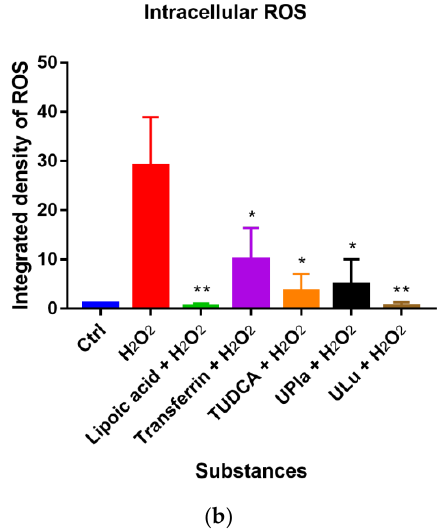
Figure 6. Intracellular ROS levels were detected by DCFH-DA staining ( a ), and the integrated fluorescence density was quantified using ImageJ ( b ). H 2 O 2 raised intracellular ROS levels (green fluorescence), which were reduced by UPla or ULu. Similar effects were observed in the positive control groups with lipoic acid, transferrin, and TUDCA. The results represent similar results of three independent experiments. Values are the mean ± SD, N = 3. * p < 0.05 vs. H 2 O 2 treatment, ** p < 0.01. 2.8. UPla and ULu Reduced Mitochondrial ROS Generation Caused by H 2 O 2 Mitochondrial ROS levels were elevated by H 2 O 2 (Figure 7), which was indicated by strong red fluorescence due to mitochondrial superoxide. The mitochondria were univer- sally marked with MitoTracker Green. Pre-treatment with UPla and ULu considerably lowered mitochondrial ROS levels, which was similar to the results obtained with lipoic acid, transferrin, and Mito-TEMPO.